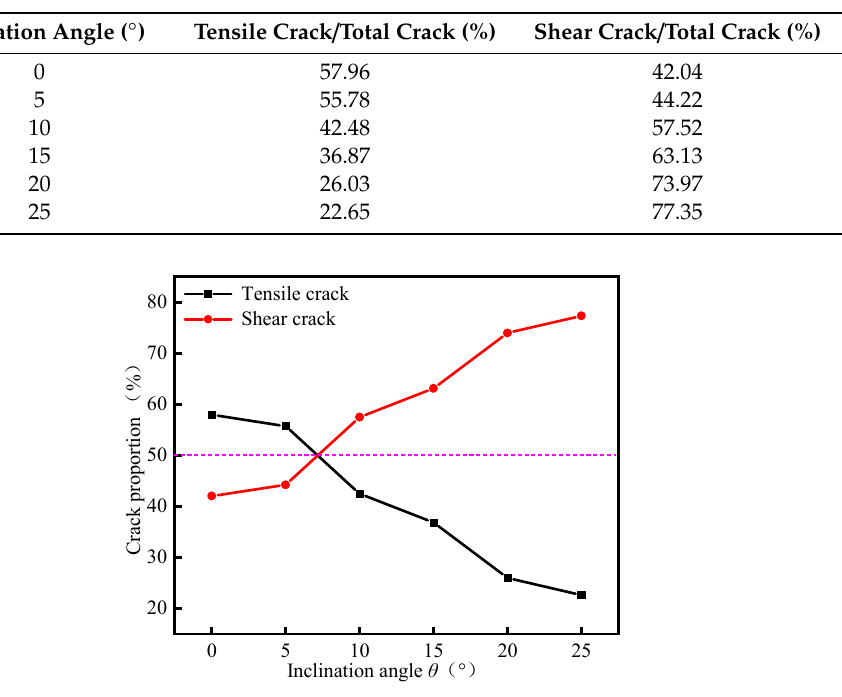
Figure 13. The proportion of tensile and shear cracks under different inclination angles at a loading rate of 1 mm/min.